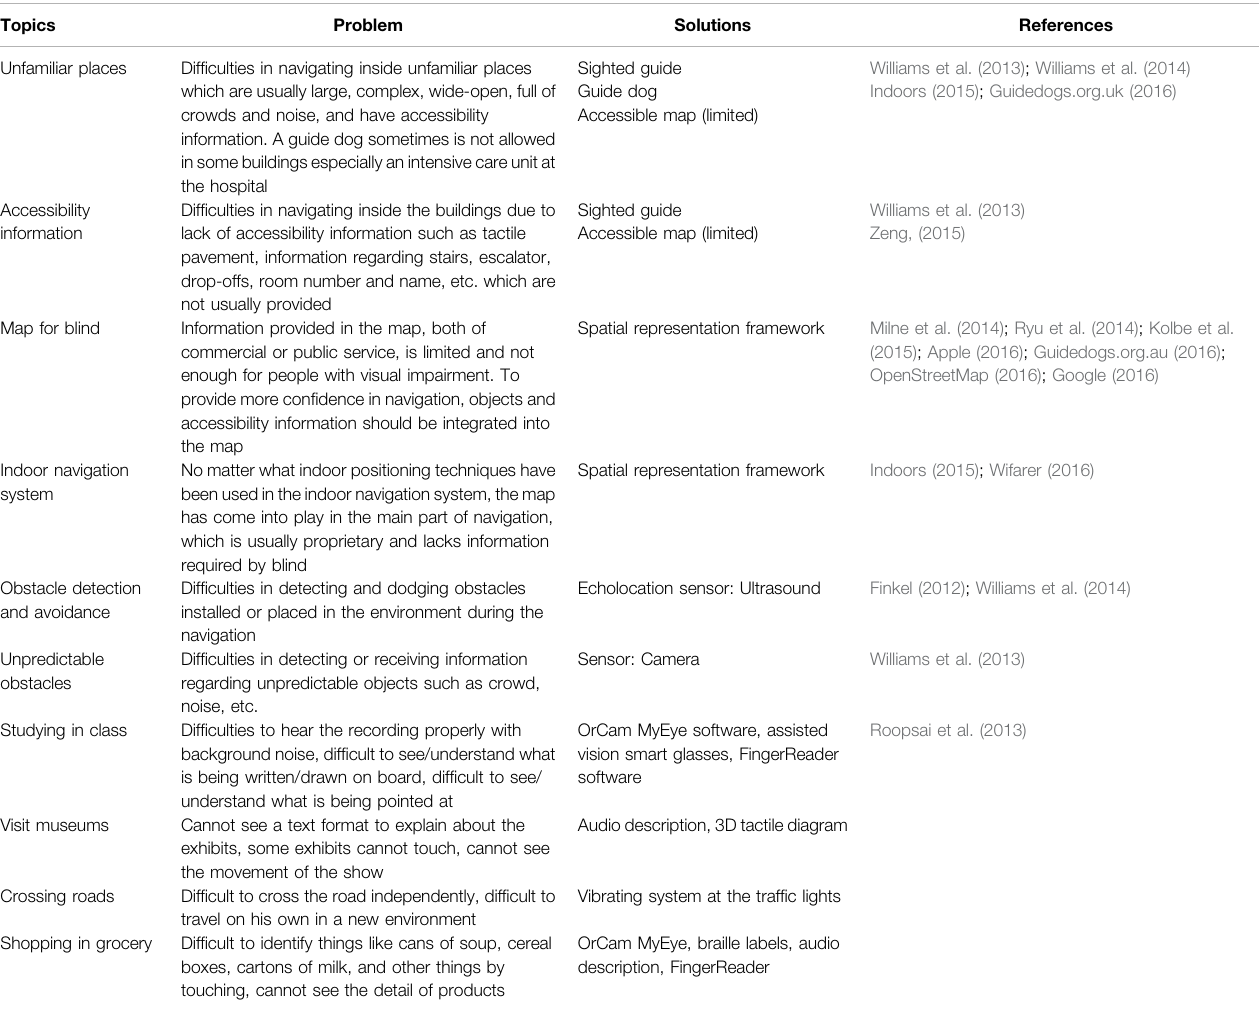
TABLE 2 | Problems and solutions experienced by visually impaired and blind